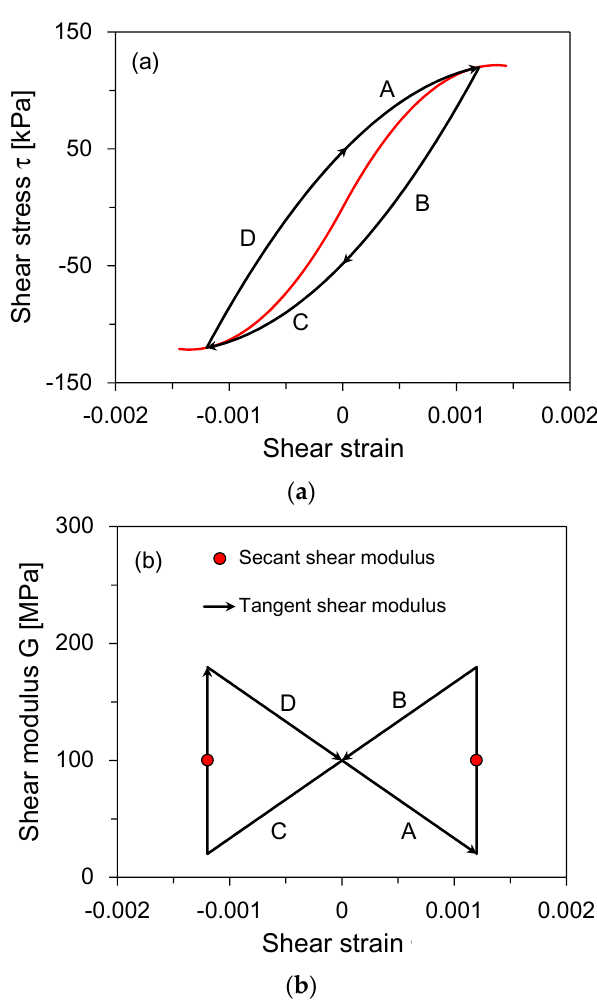
Figure 2. Evolution of the shear modulus along the A → B → C → D loading path for the given shear strain amplitudes of ∆ γ = 1.2 × 10 − 3 . ( a ) Hysteresis loop and ( b ) Shear modulus. The tangent shear modulus is calculated from Equation (2). Circles indicate the secant shear modulus. Note that G sec ( ∆ γ ) is equal to the average of the tangent moduli at ± γ .